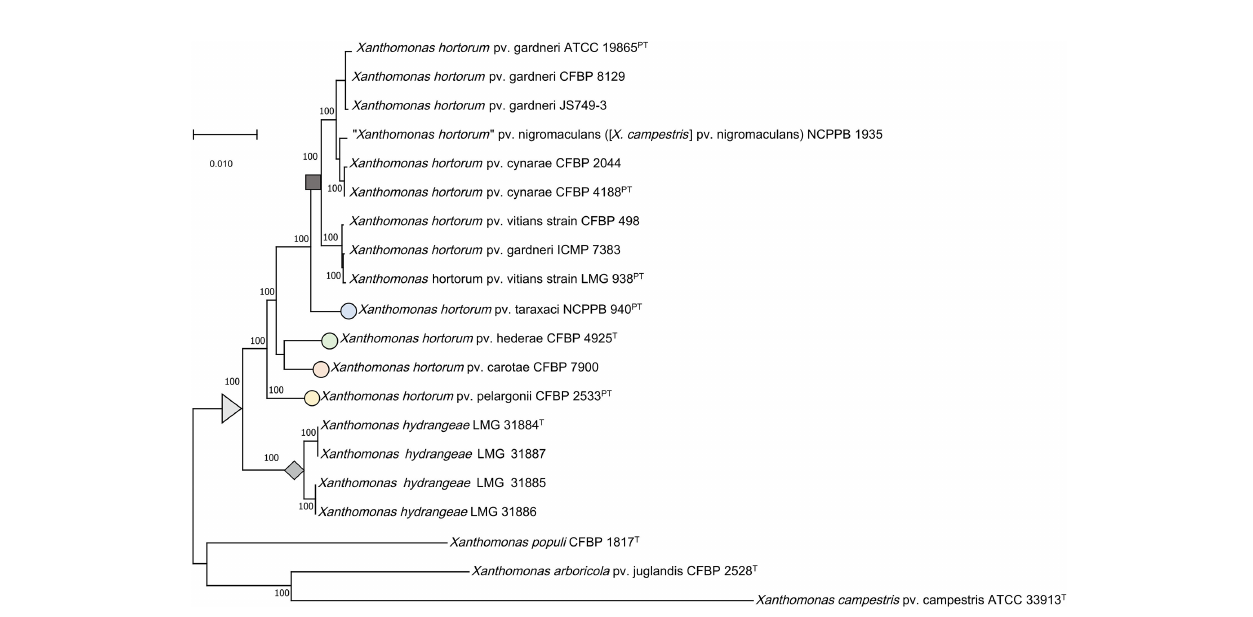
FIGURE 2 | Whole-genome Maximum-Likelihood core phylogeny of the Xanthomonas hortorum – Xanthomonas hydrangeae species complex. The tree shows the various clades within the species complex (grey arrow): clades A1 ( X. hortorum pvs. gardneri, cynarae, vitians and [ X. hortorum ] pv. nigromaculans, grey square) and A2 ( X. hortorum pv. taraxaci, blue circle), clades B1( X. hortorum pv. hederae, green circle), B2 ( X. hortorum pv. carotae, red circle) and B3 ( X. hortorum pv. pelargonii, yellow circle), and clade C ( X. hydrangeae , grey diamond) in addition to three outgroup strains. Accession numbers of the 20 genomes used in this study are noted in Table 1 .